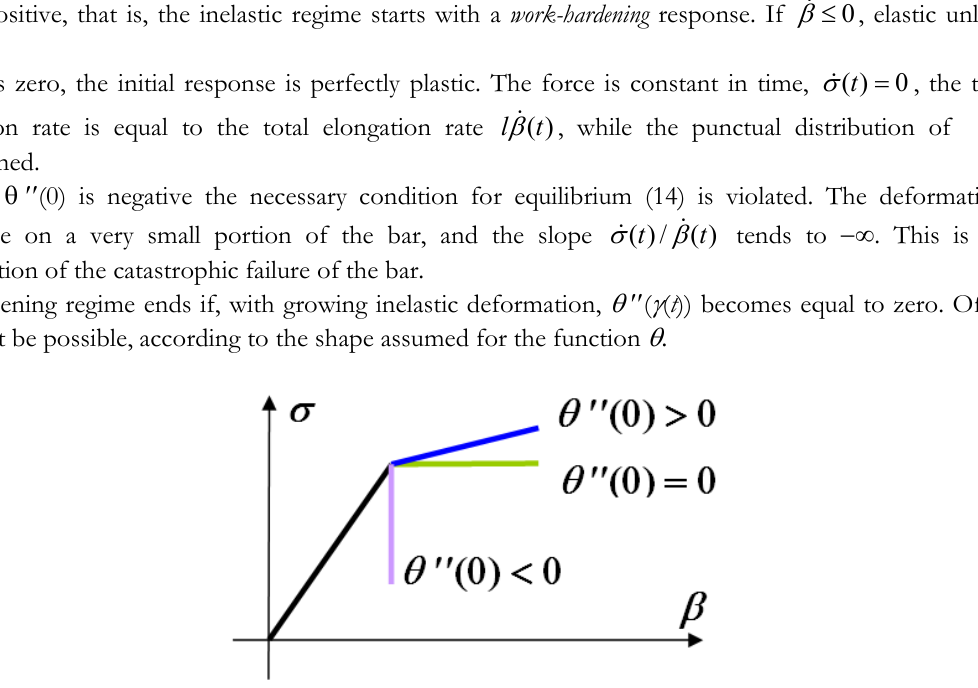
Figure 1: Force-elongation response curves at the onset of the inelastic regime, for different signs of  (0)